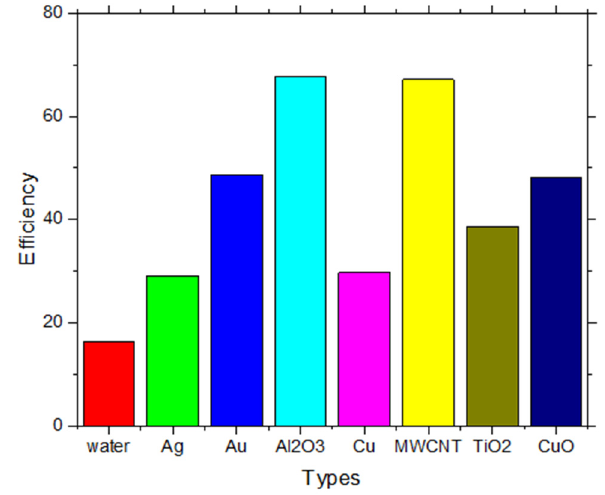
Figure 10. Absorption efficiency of a single nanofluid.